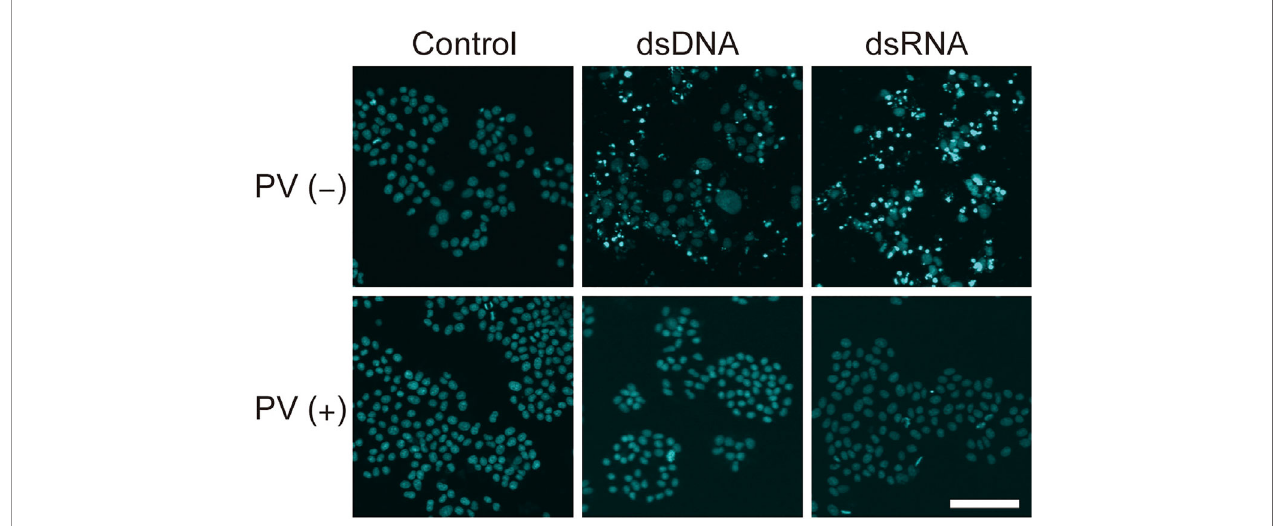
FIGURE 5 | PV exerts a protective effect on cell death in FRTL-5 cells induced by dsDNA or dsRNA. FRTL-5 cells were cultured with or without PV at 350 m g/mL for 24 h. Cells were then stimulated with 1 m g/mL dsDNA or dsRNA for 24 h, followed by Hoechst 33342 staining. Fluorescence was observed using a confocal laser scanning microscope. Scale bar, 100µm.